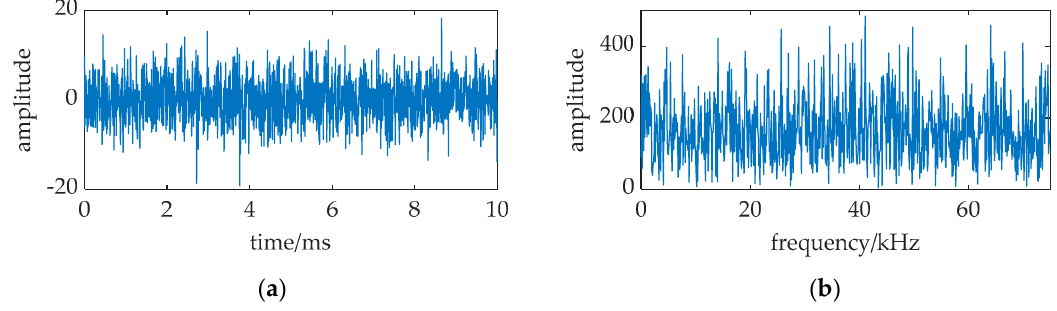
Figure 2. The received signal at 2 km distance. ( a ) waveform of the received signal; ( b ) frequency spectrum of the received signal.